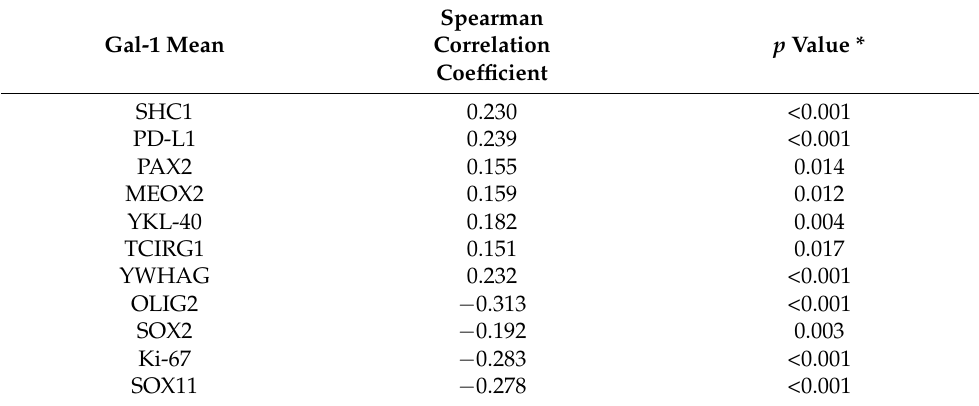
Table 4. Correlation between Gal-1 mean H-score expression and markers related to molecular subtypes.